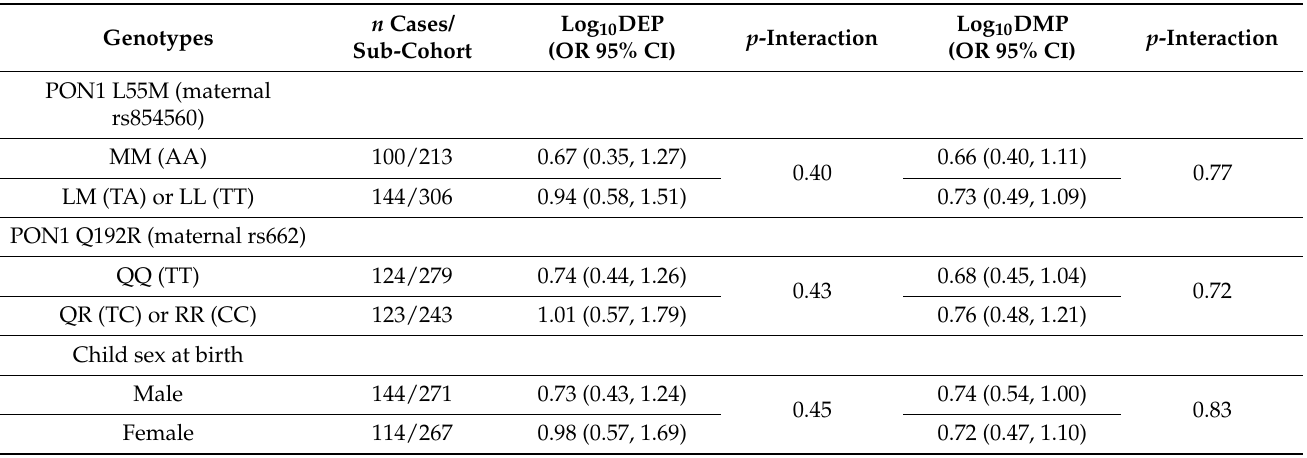
Table 5. Assessment of modification by variation in PON1 single-nucleotide polymorphism genotypes and child